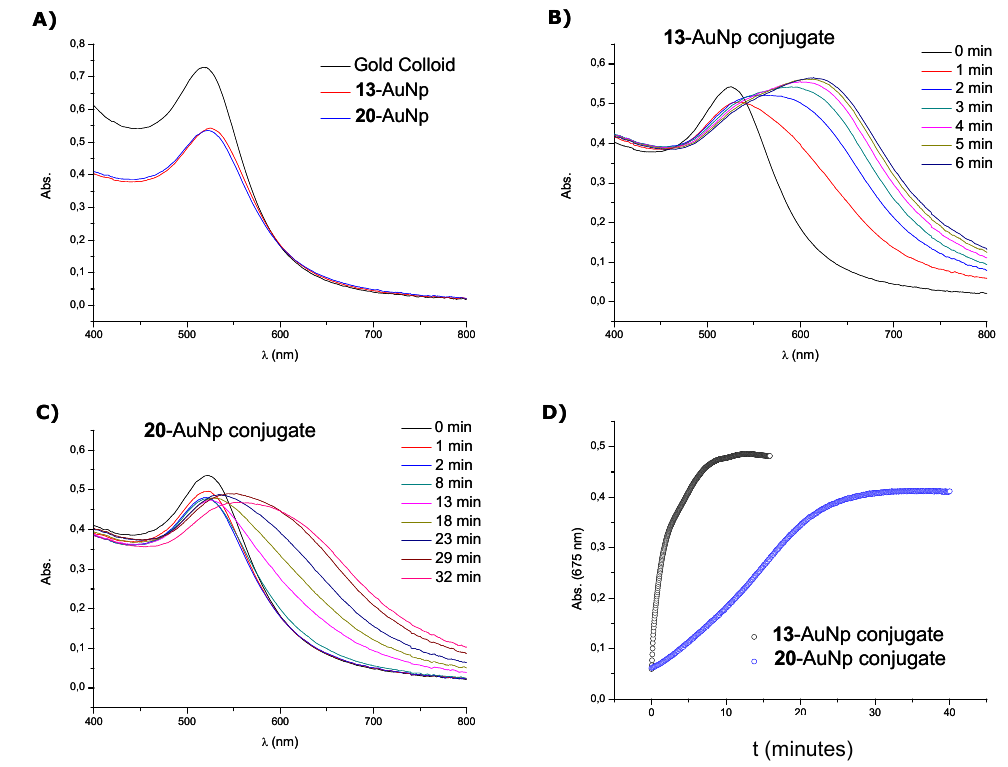
Figure 3. ( A ) UV-vis spectra of the initial gold nanoparticle solution and the functionalized gold nanoparticles with oligonucleotides 13 and 20 . Time evolution of UV-Vis spectra of gold nanoparticle conjugates in 10 mM DTT. ( B ) Disulfide oligonucleotide 13 . ( C ) Thiol oligonucleotide 20 . ( D ) Absorbance changes monitored with time at 675 nm for both